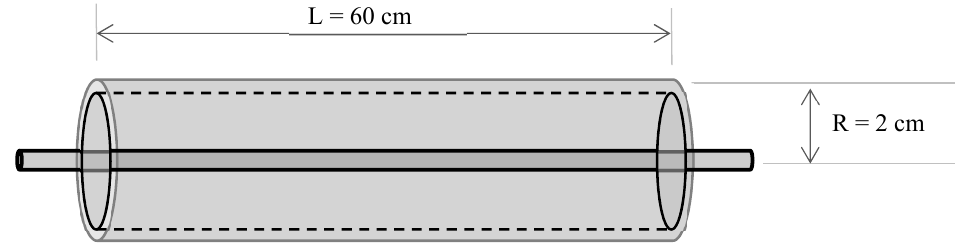
Figure 1. PL processing chamber. The chamber has an annular design inside which the liquid is housed and treated by PL lamps placed at the axis of chamber. Suitable for batch or continuous processing.